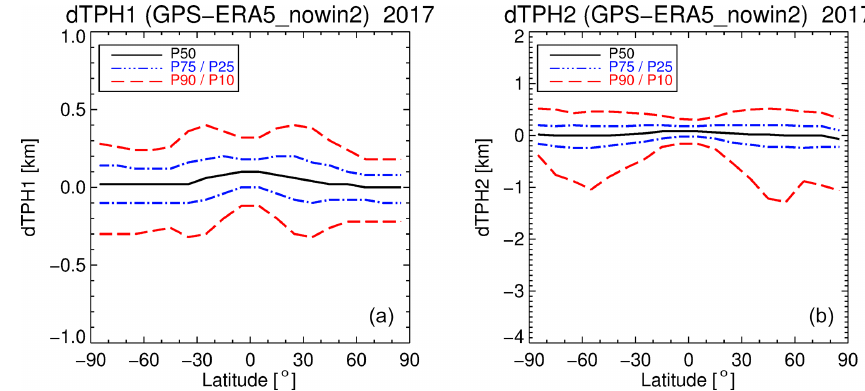
Figure C1. Zonal percentiles of P 10 , P 25 , P 50 (median), P 75 , and P 90 of the difference in tropopause heights between GPS and ERA5 for 2017 for the first (a) and second (b) lapse rate tropopause and non polar-winter conditions (for details see